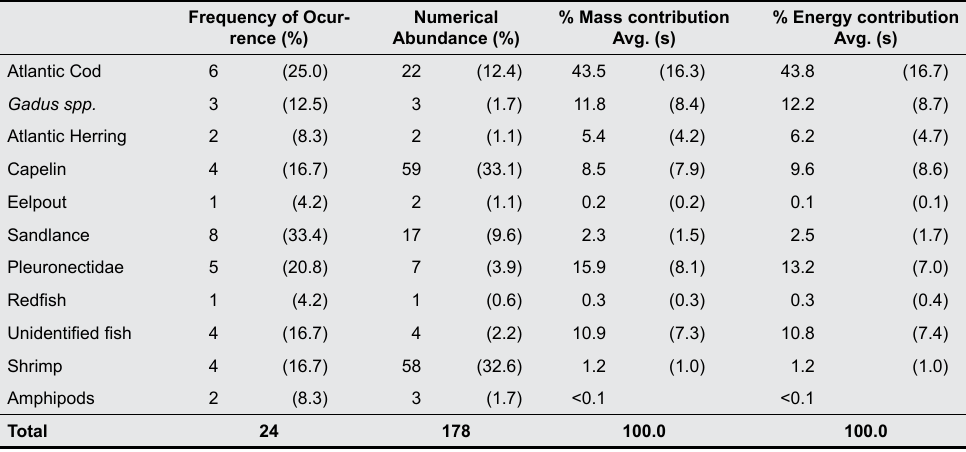
Table 9. Diet composition of 24 seals collected from the south coast of Newfoundland between 1985 and 2004. Frequency of occurrence and % frequency of occurrence in parentheses, numeri- cal abundance with relative percent in parenthesis, and percent (%) mass and energy contribu- tion to the diet with average and standard deviation in parentheses.